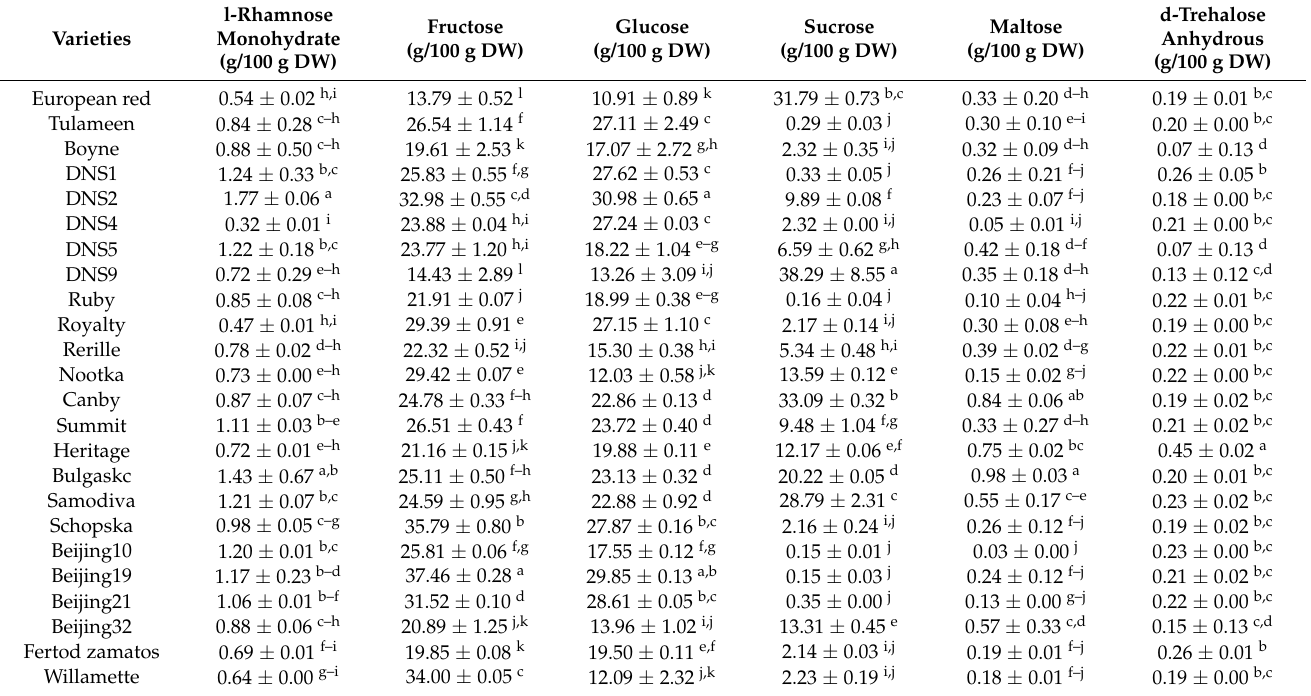
Table 3. Individual sugar contents of 24 red raspberry